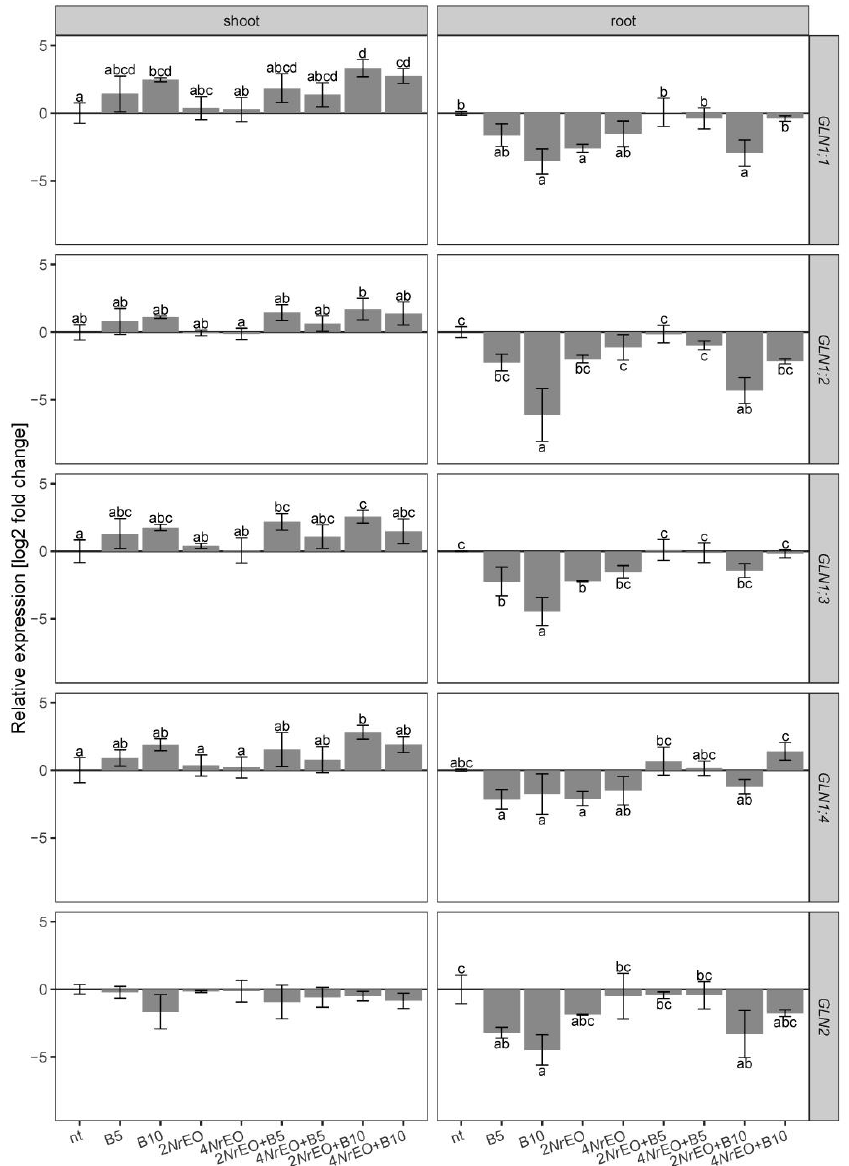
Figure 3. The effects of BASTA applied at two concentrations B5 (5 mg L − 1 ) and B10 (10 mg L − 1 ), N. rtanjensis essential oil applied at two concentrations 2% (2 Nr EO) and 4% (4 Nr EO), and of their combinations on the relative expression of GS coding genes in Arabidopsis shoots and roots, measured 10 days after the beginning of the treatment, grown in vitro . Values are presented as means ± SD. Letters above the bars denote significant differences according to Tukey’s HSD post-hoc test at p < 0.05. The expression of GLN1;5 was not detected.